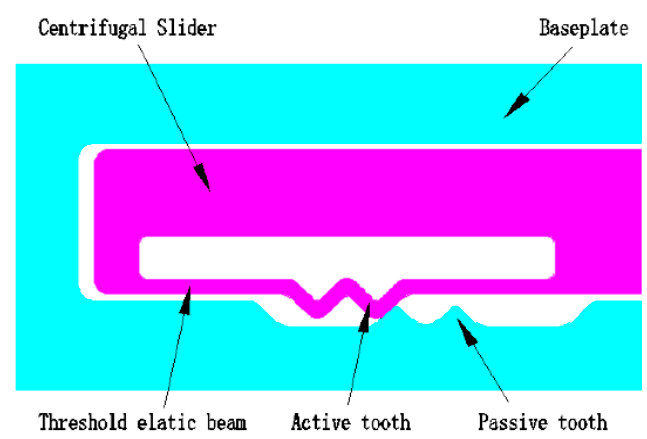
Figure 2. The elastic-beam delaying mechanism.